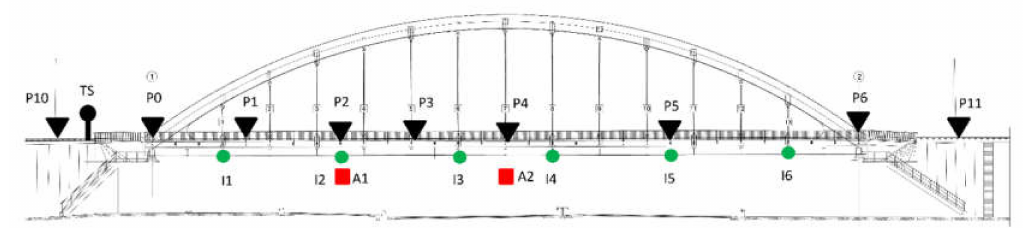
Figure 4. Diagram of inclinometer locations (I1, I2, and I3) and accelerometer location (A1)